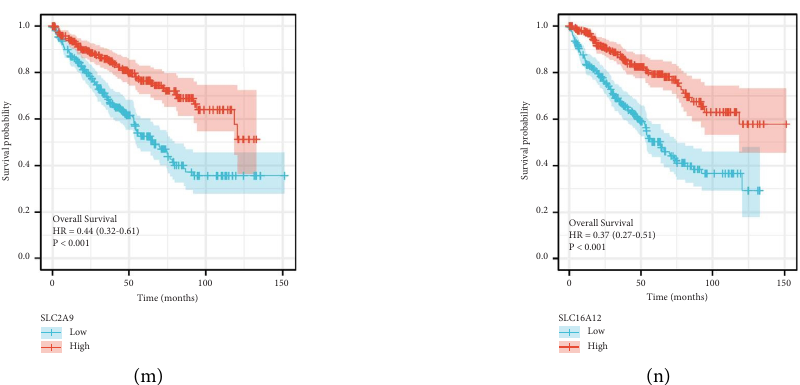
Figure 4: (a) Te heatmap shows the correlation between the risk score and clinical characteristics. Te histogram reveals the relationship between risk score and age (b), gender (c), grade (d), stage (e), T stage (f), M stage (g), and N stage (h) Te survival analysis between the low- and high-expression groups of ANK3 (i), EMX2 (j), IGF2BP2 (k), METTL7A (l), SLC2A9 (m), SLC16A12